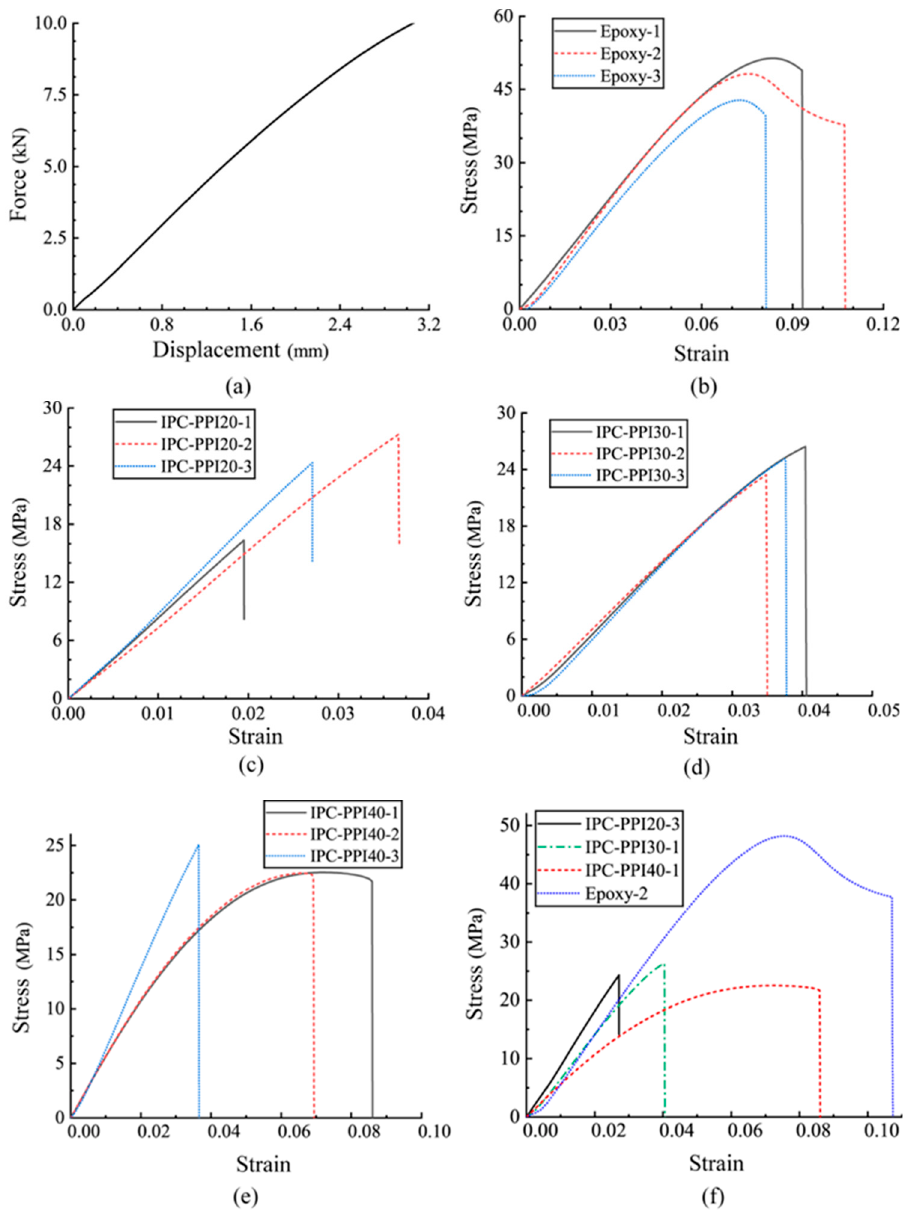
Figure 10. Stress–strain curve of tensile specimen: ( a ) fixture force-displacement curve; ( b ) epoxy resin; ( c ) composite PPI20; ( d ) composite PPI30; ( e ) composite PPI40; ( f ) comparison of epoxy and composites.